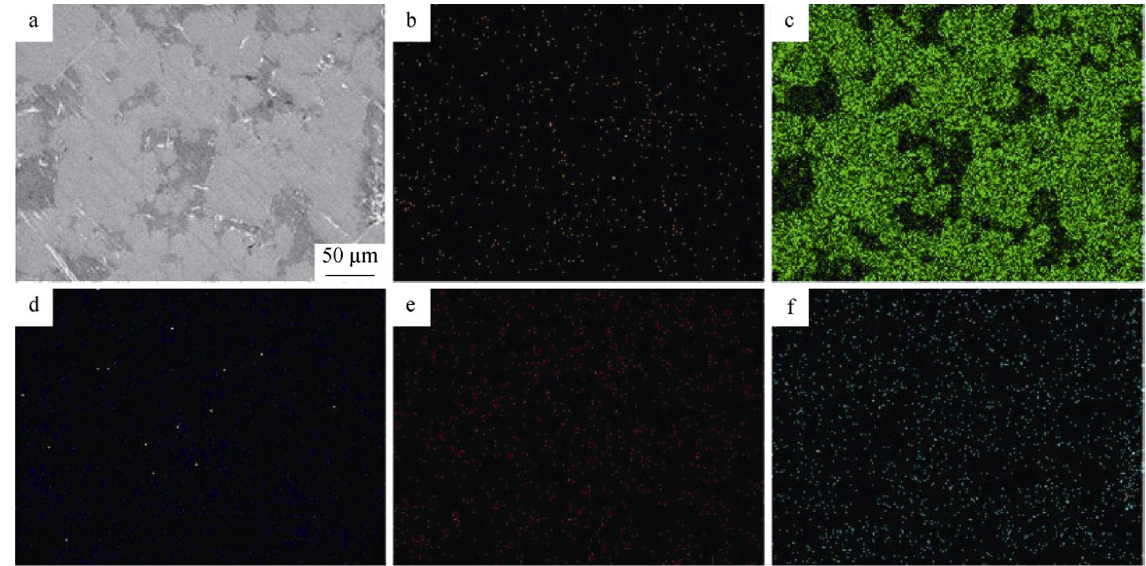
Figure 10. Elemental distribution of SEM micrograph on ( a ) spark-plasma-sintered W-7Ni-3Fe-0.5La 2 O 3 ; ( b ) Ni; ( c ) W; ( d ) Fe; ( e ) La; and ( f ) O [75]. Reproduced with permission from Muthuchamy et al., Rare Metals; published by Springer, 2020 Table 4. Mechanical properties of W–Ni–Fe with lanthanum oxide.